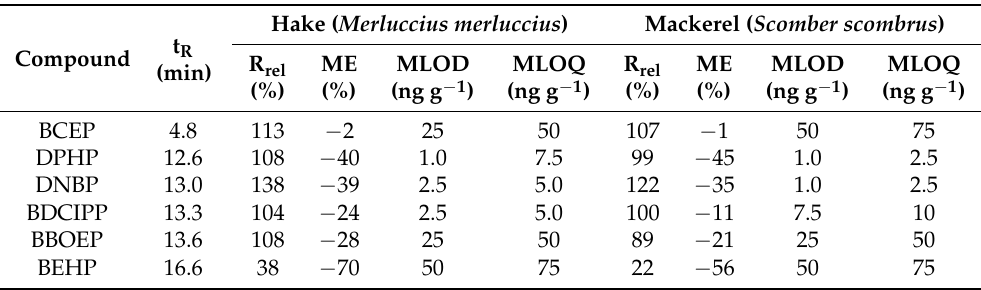
Table 2. Retention time (t R ), relative recovery (R rel ), matrix effect (ME), method limit of detection (MLOD) and method limit of quantification (MLOQ) for two representative species.